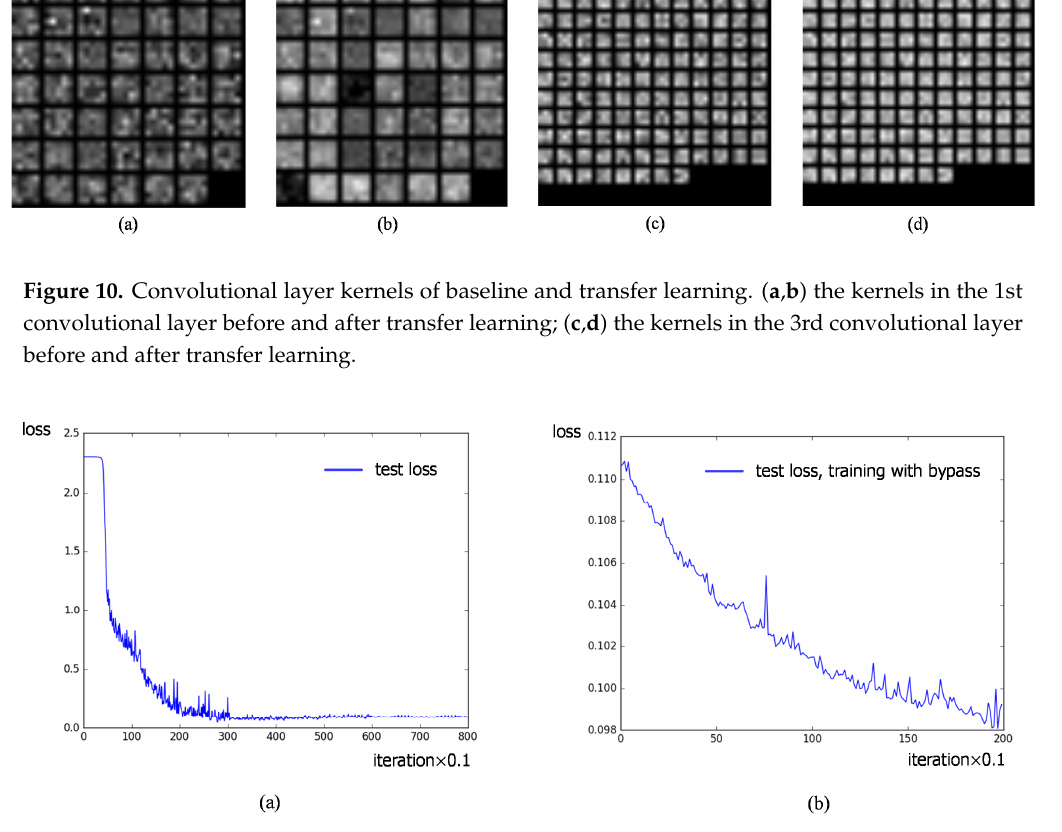
Figure 11. Testing loss curve during training. ( a ) the testing curve during transfer learning; ( b ) the testing curve after attaching the